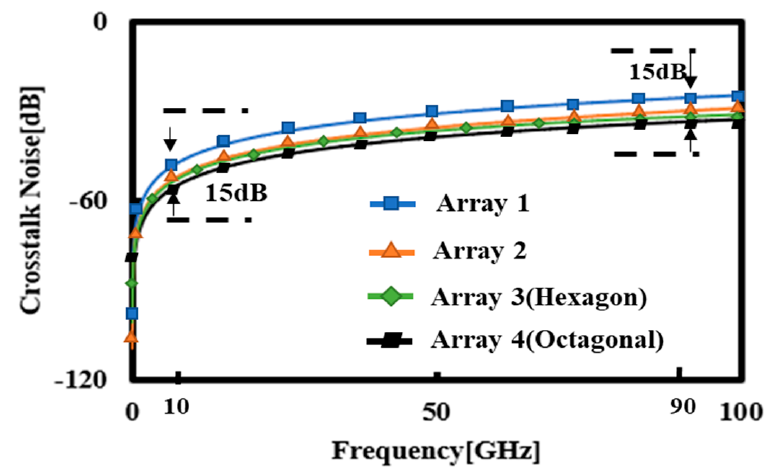
Figure 9. The crosstalk noise among arrays 1, 2, 3 and 4.